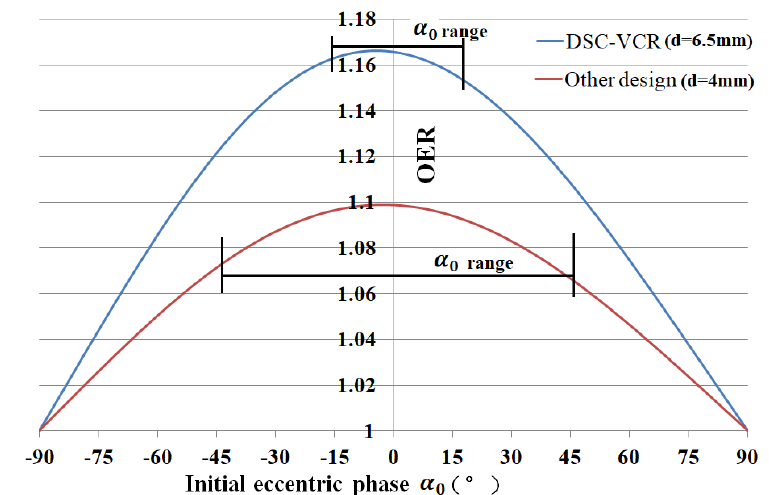
Figure 4. Variation of the OER with initial eccentric phase α 0 .